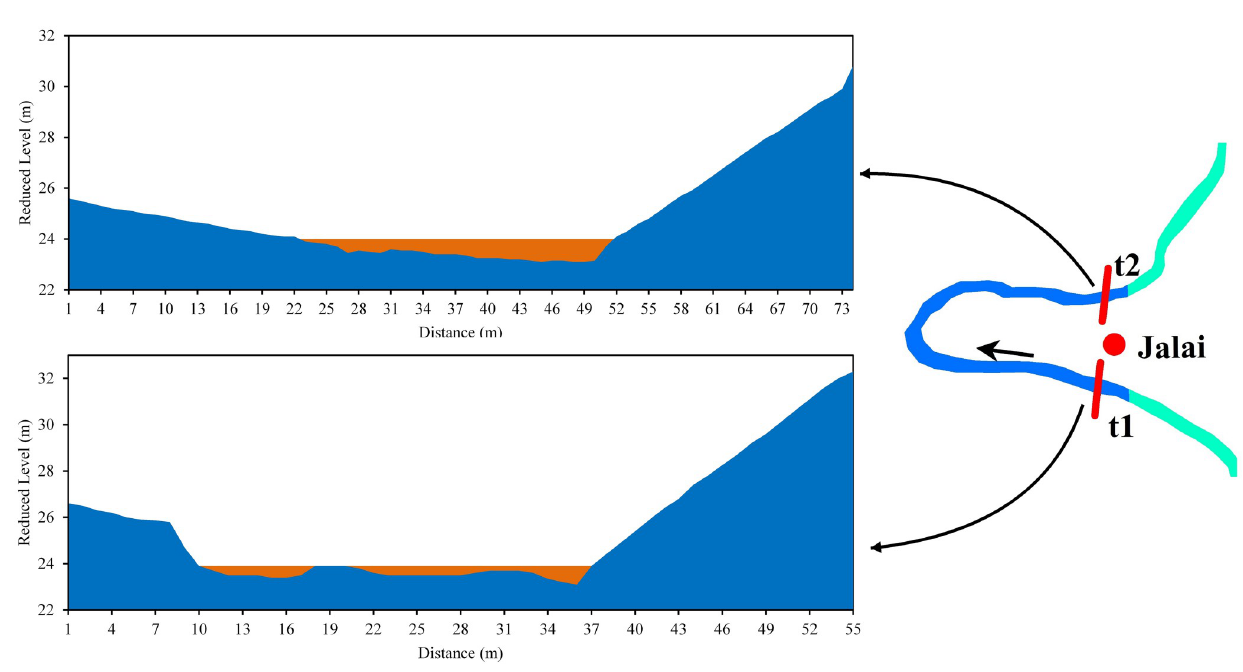
Fig 12. Cross-section across the Manu River at Jalai (a) t1 (b)